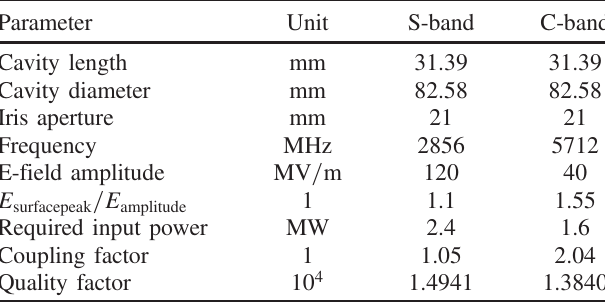
TABLE I. rf parameters of the 0.6 cell